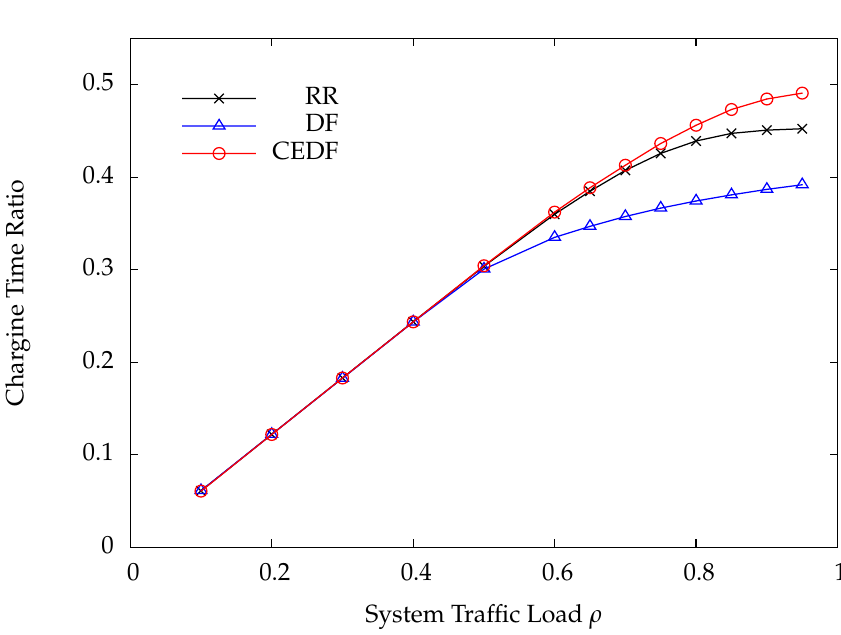
Figure 9. Charging time ratio versus system traffic load ρ